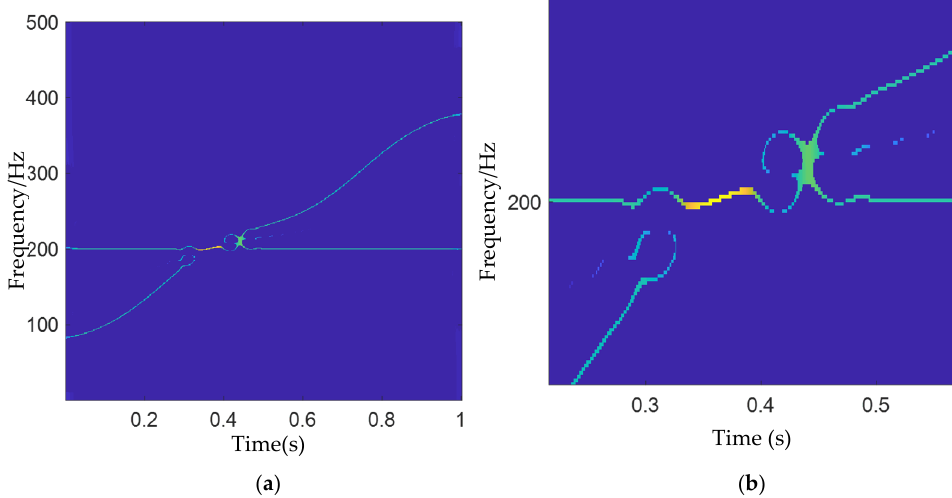
Figure 11. TF distribution of f ( t ) based on GLCT. ( a ) TF distribution ( b ) Local enlarged figure